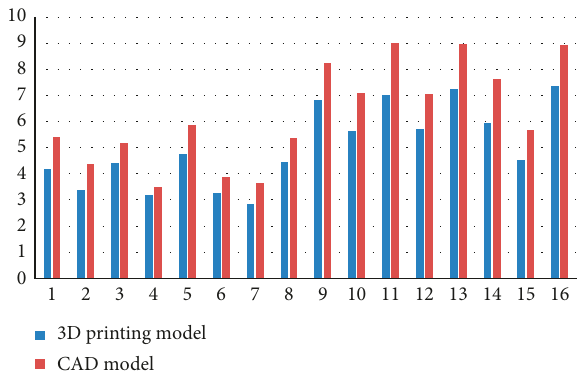
Figure 9: Measurement results of 3D printing models and CAD models.